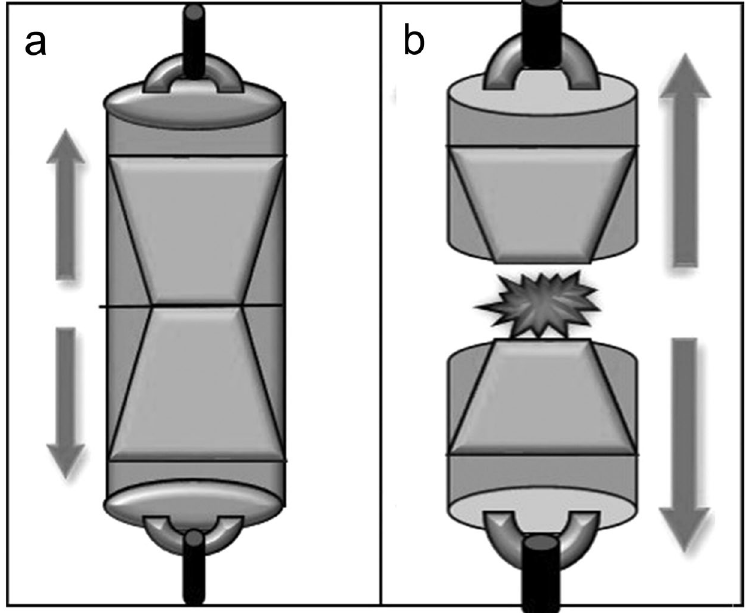
Figure 2. Schematic of the tensile test. ( a) Before testing. ( b) After stressing the bonded assembly to